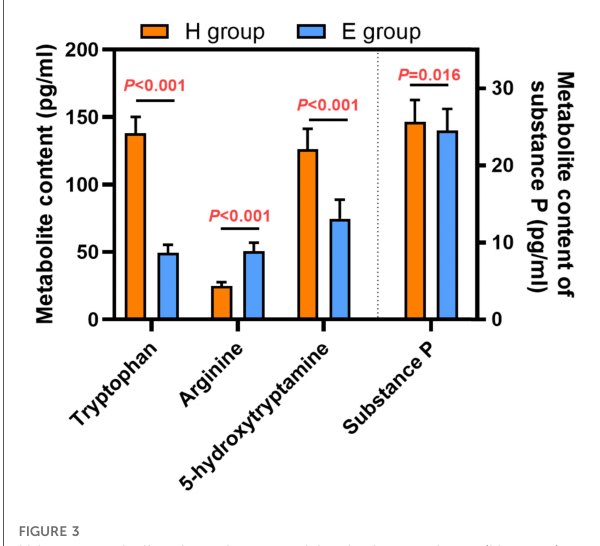
FIGURE 3 Urinary metabolites in patients receiving hydromorphone (H group) or esketamine (E group). Data are mean±standard